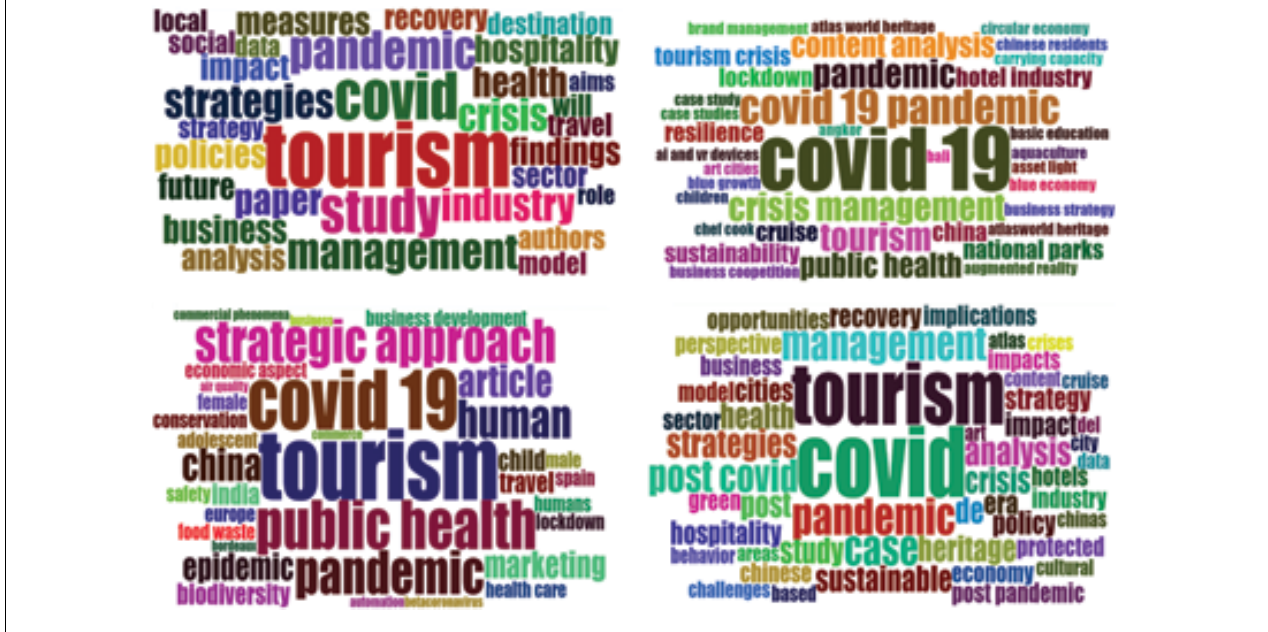
FIGURE 3 | Keyword analysis.